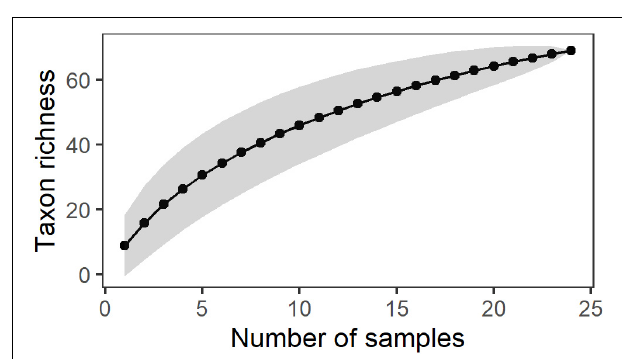
FIGURE 3 | Species accumulation curve of meroplankton taxa in the Barents Sea north and south of the Polar Front covering a seasonal cycle.